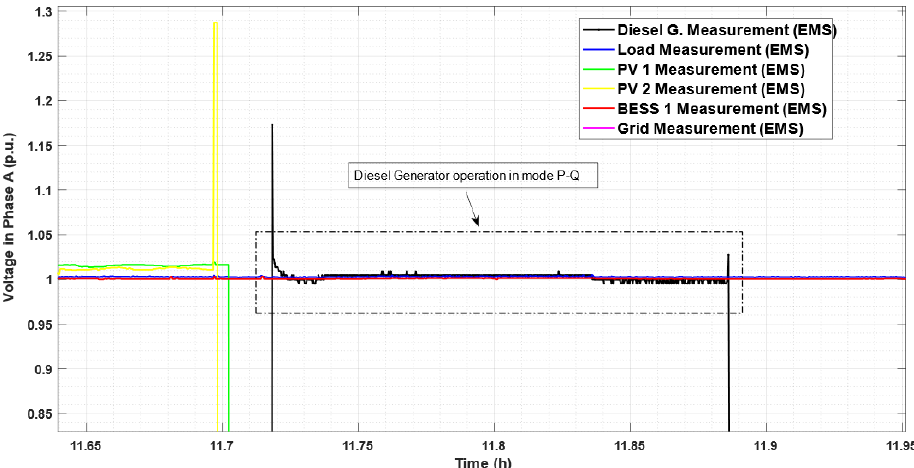
Figure 11. The voltage of microgrid components focusing on diesel